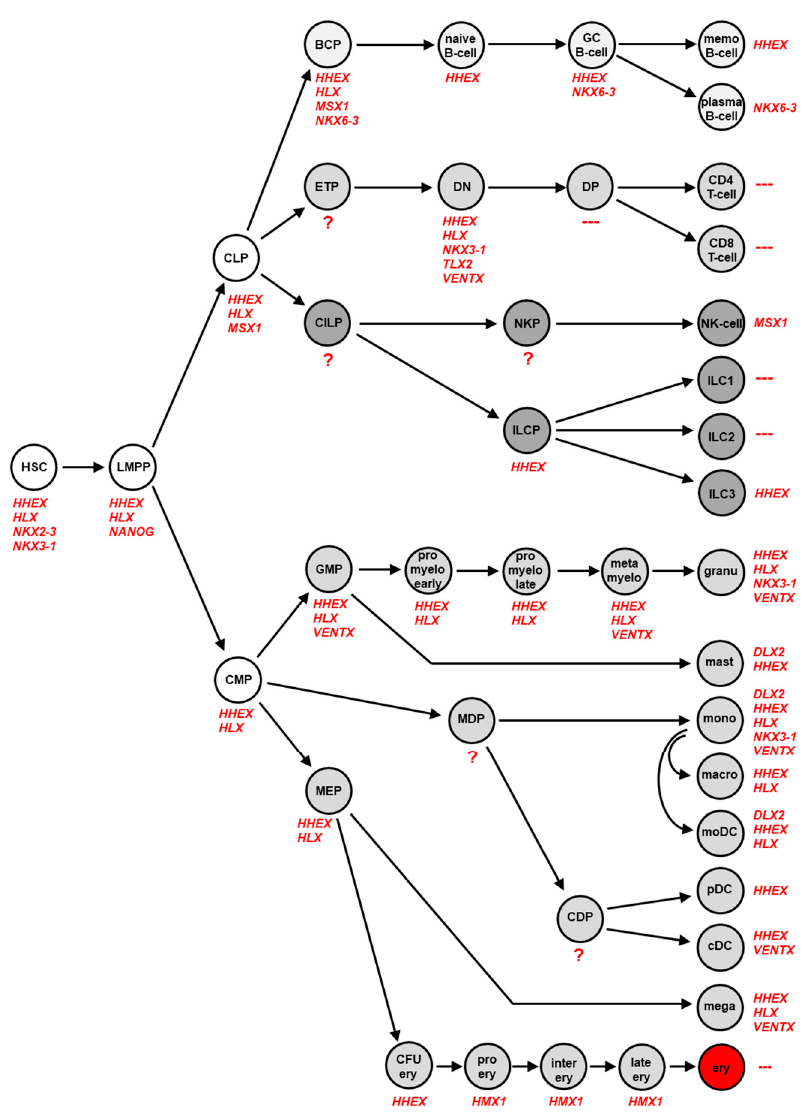
Figure 2. The NKL-code in lymphopoiesis This diagram depicts activities of NKL homeobox genes during early hematopoiesis, in lymphopoiesis including development of T-cells, B-cells, NK-cells and ILCs, and in myelopoiesis. Each cell-type/stage is labelled with the accordingly expressed NKL homeobox genes. BCP: B-cell progenitor, cDC: conventional dendritic cell, CDP: common dendritic progenitor, CILP: common innate lymphoid progenitor, CLP: common lymphoid progenitor, CMP: common myeloid progenitor, DN: double negative, DP: double positive, ETP: early T-cell progenitor, GC B-cell: germinal center B-cell, GMP: granulocytic-monocytic progenitor, HSC: hematopoietic stem cell, ILC(P): innate lymphoid cell (progenitor), LMPP: lymphoid and myeloid primed progenitor, memo B-cell: memory